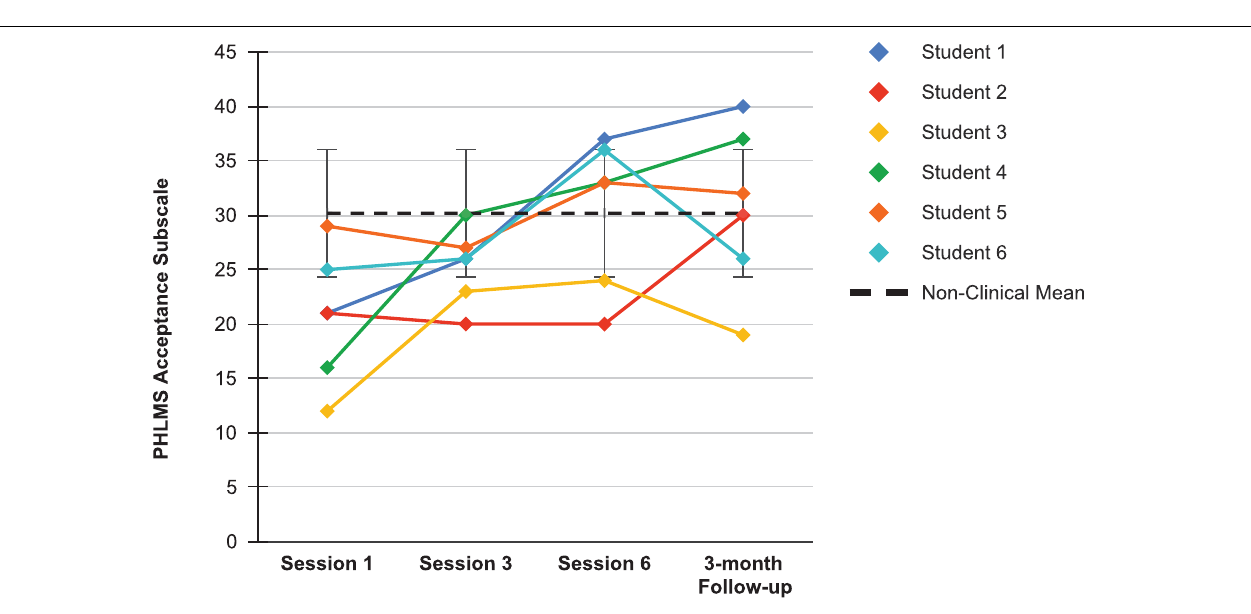
FIGURE 6 | PHLMS Acceptance subscale scores for the current students, from pre-coaching (Session 1), midway (Session 3), post-coaching (Session 6), and the 3-month follow-up, with the non-clinical mean (30.19) and bars spanning one standard deviation up/down ( SD = 5.84; Cardaciotto et al.,